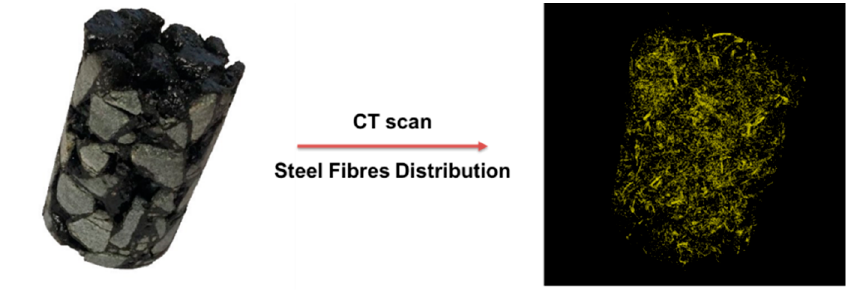
Figure 3. Steel Wool Fibre (SWF) distribution study with XCT.